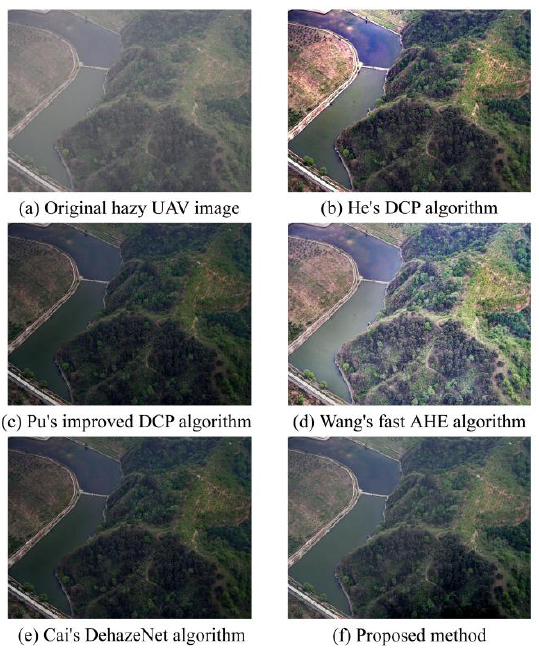
Figure 5. Comparison of different methods on images of river: (a) Original hazy UAV image. (b) He's Dark Channel prior algorithm. (c) Pu's Improved DCP algorithm. (d) Wang's fast adaptive histogram equalization algorithm. (e) Cai's DehazeNet algorithm. (f) Proposed method